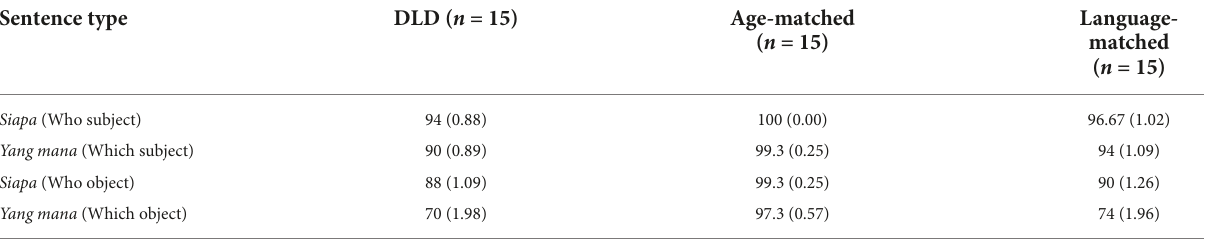
TABLE 5 Comprehension of Wh- questions (standard deviation) for the three groups.